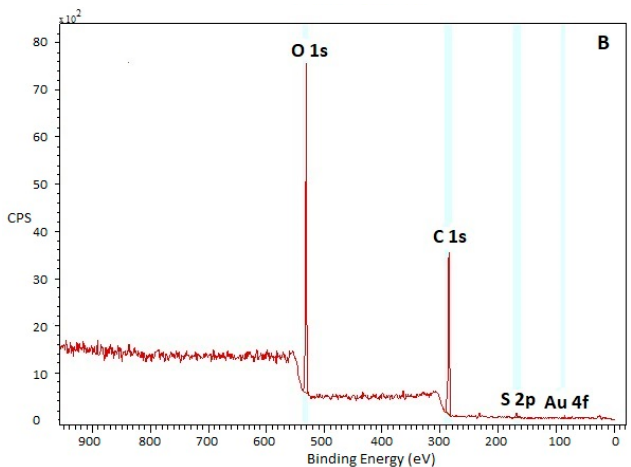
Figure 2. XPS spectrum of pristine PVA ( A ) and PVA doped with Au nanoparticles in a PEG colloid solution ( B ).